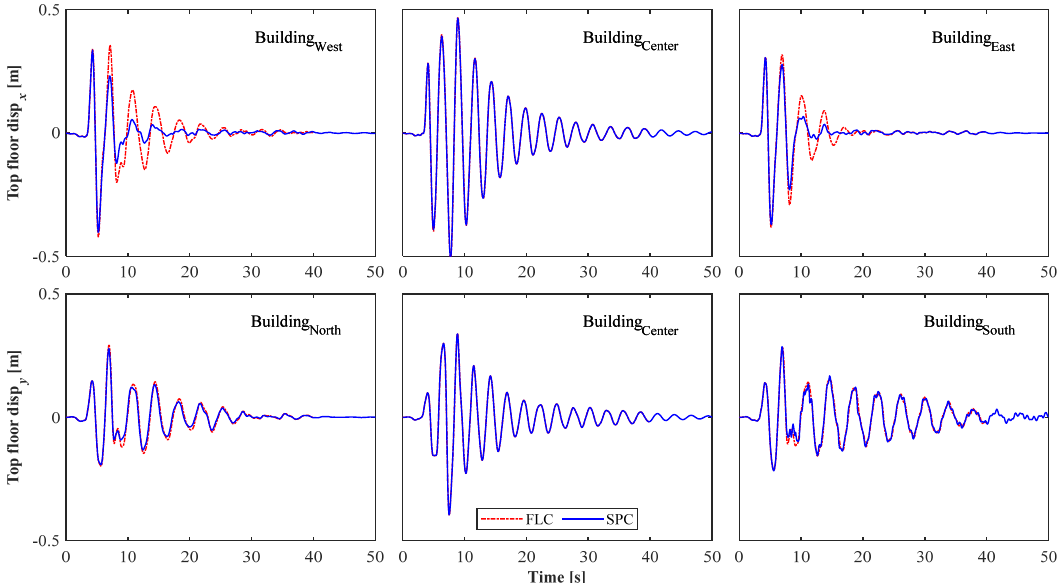
Figure 19. The response of the adjacent buildings considering damage in the central building using SPC.